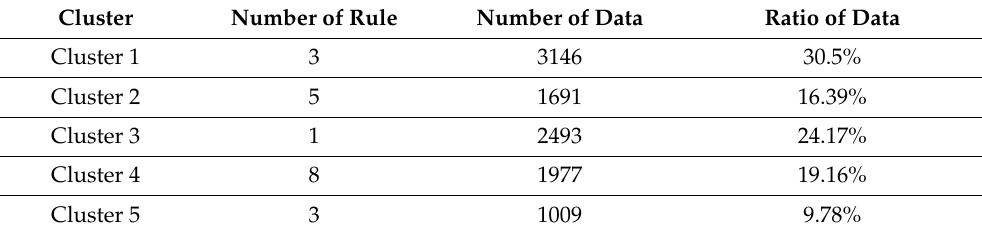
Table 2. Summary of clusters.